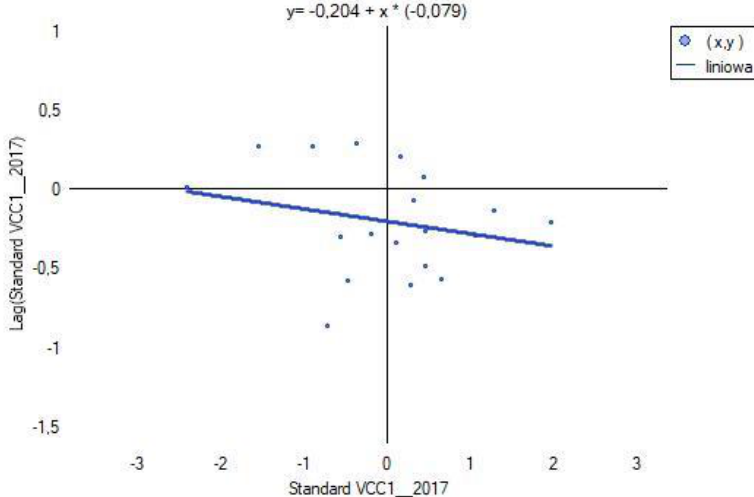
Figure 15. Chart of the global Moran’s index I for VCC1. Source: own study.